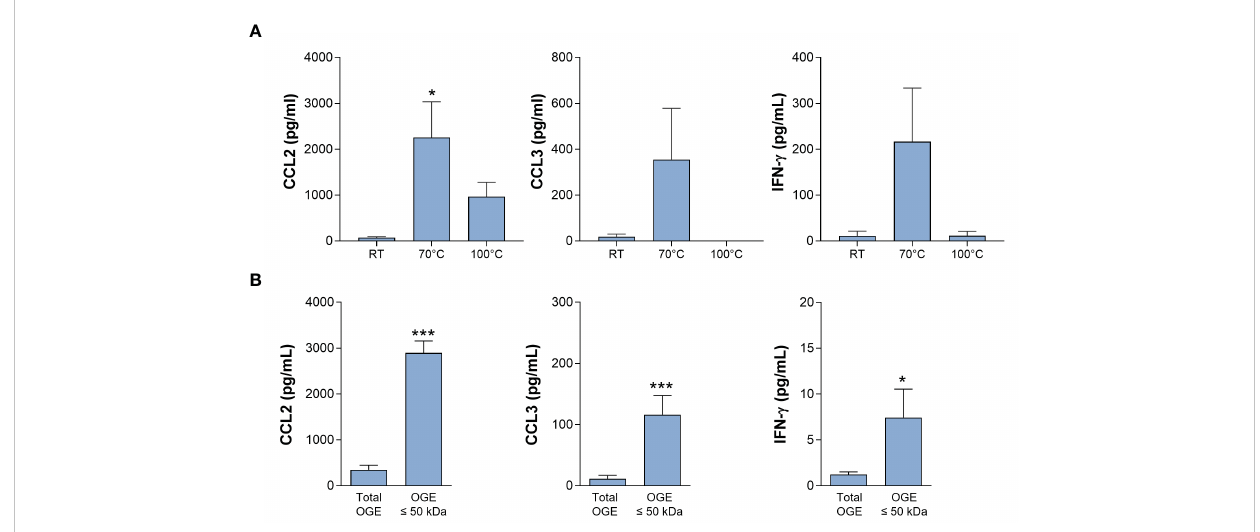
FIGURE 3 Bioactivity of the octyl-glucoside extract (OGE) of T. cruzi trypomastigote lysate. Ten-fold diluted whole cord blood from healthy newborns were cultured with the OG extract of trypomastigote lysate, either pretreated at room temperature (RT), 70°C or 100°C for 30 min (A) or fi ltered in order to conserve molecules of molecular mass ≤ 50 kDa (B) . Cultures were performed during 24h for CCL2 and CCL3 production or 72h, in the presence of IL-2 (5U/mL) and IL-18 (10ng/mL), for IFN- g production). Results are expressed as mean ± SEM (A: n=4; B: n=10). *P<0.05, ***P< 0.005 vs. RT or un fi ltered extract ( “ total extract ” ) (Wilcoxon test).